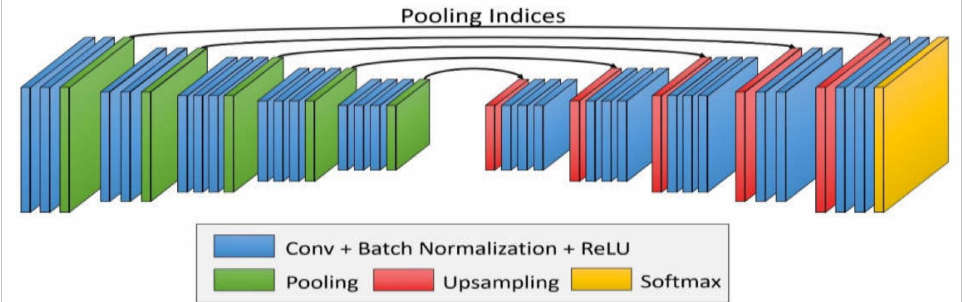
Figure 6. SegNet structure illustration (reproduced from Badrinarayanan et al. [32]).